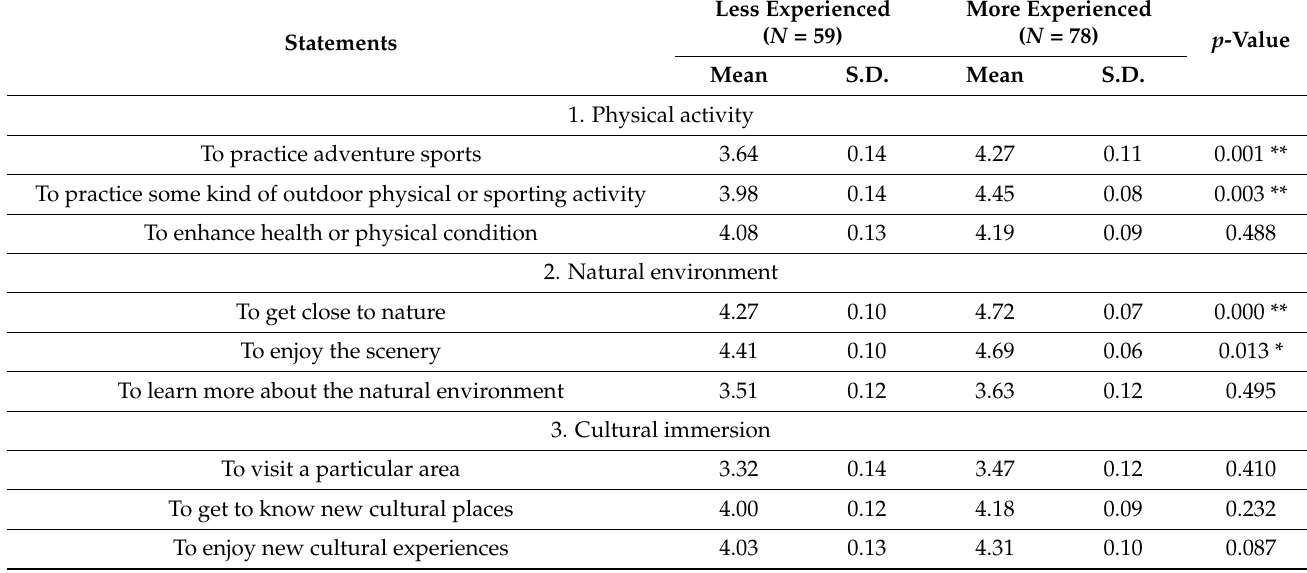
Table 2. Importance of motives for visiting a national or natural park.